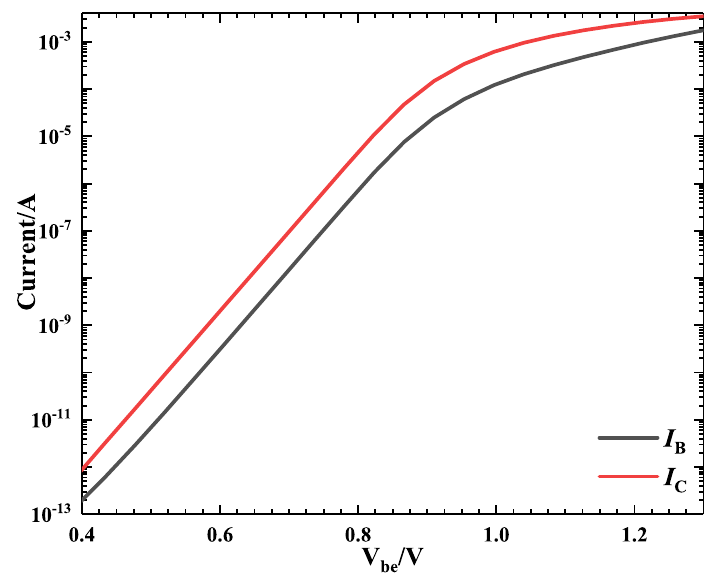
Figure 3. Gummel characteristic curve of the SiGe